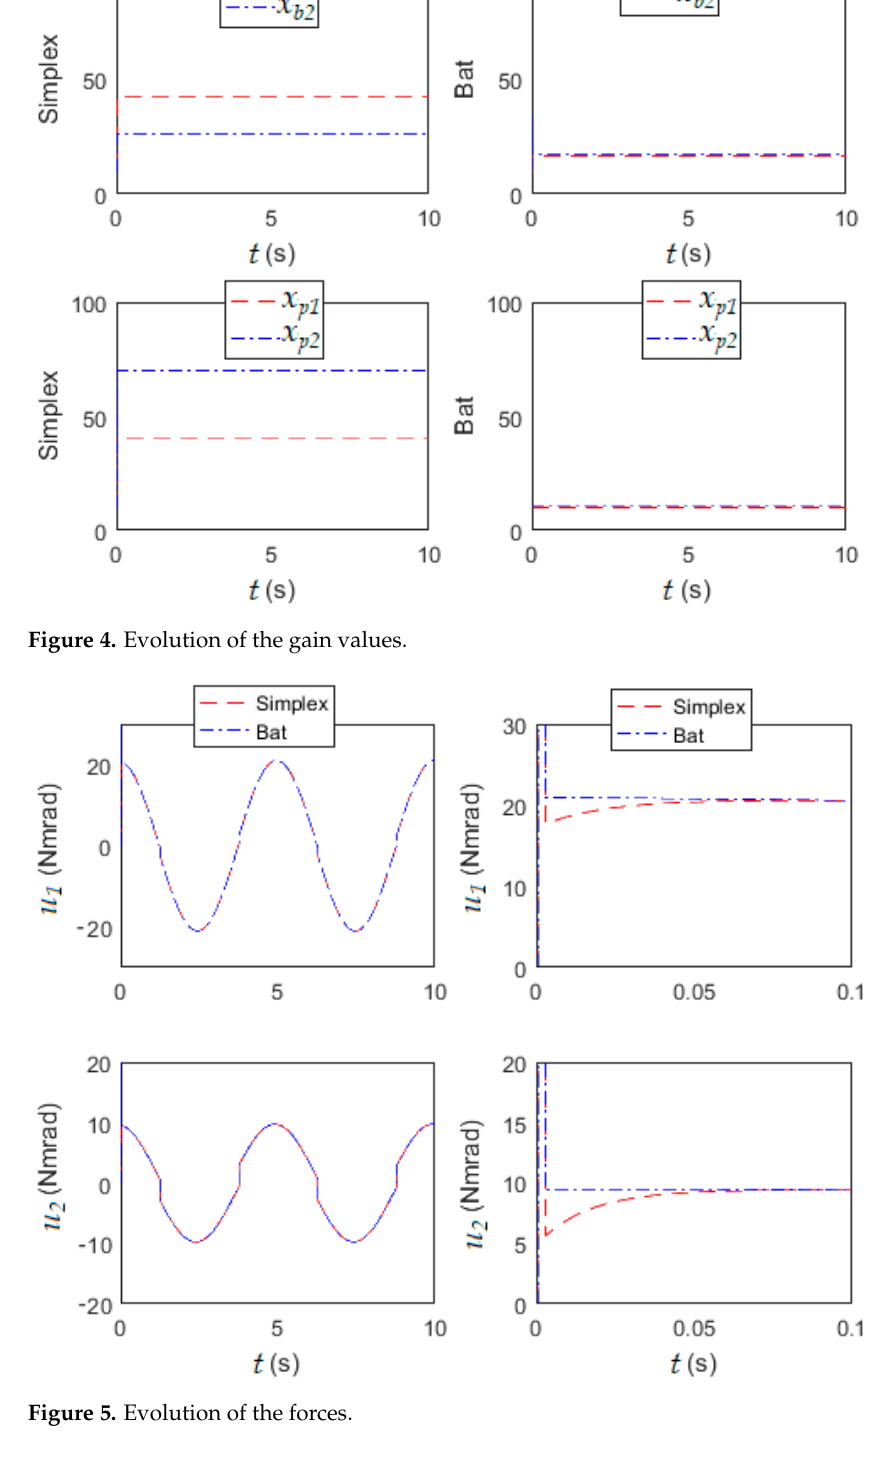
Figure 6. Evolution of the joint positions.